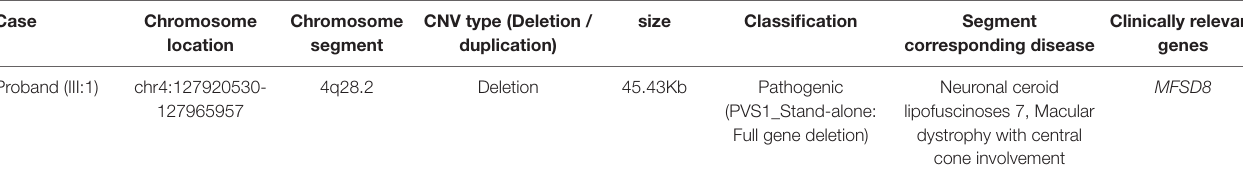
TABLE 2 | The result of